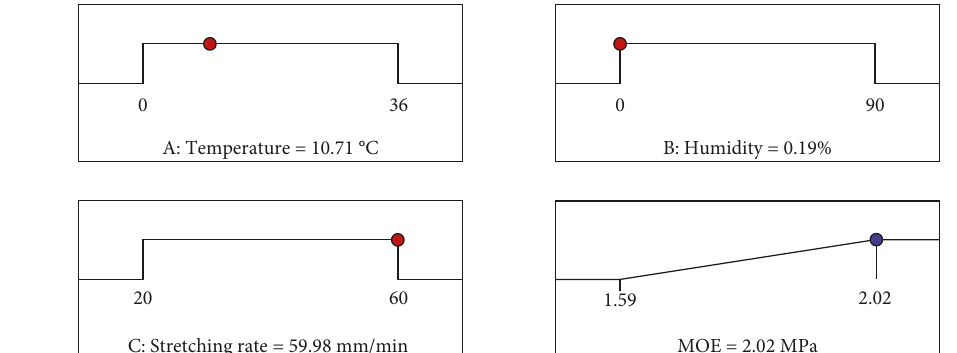
Figure 5: Prediction of cutting parameters.